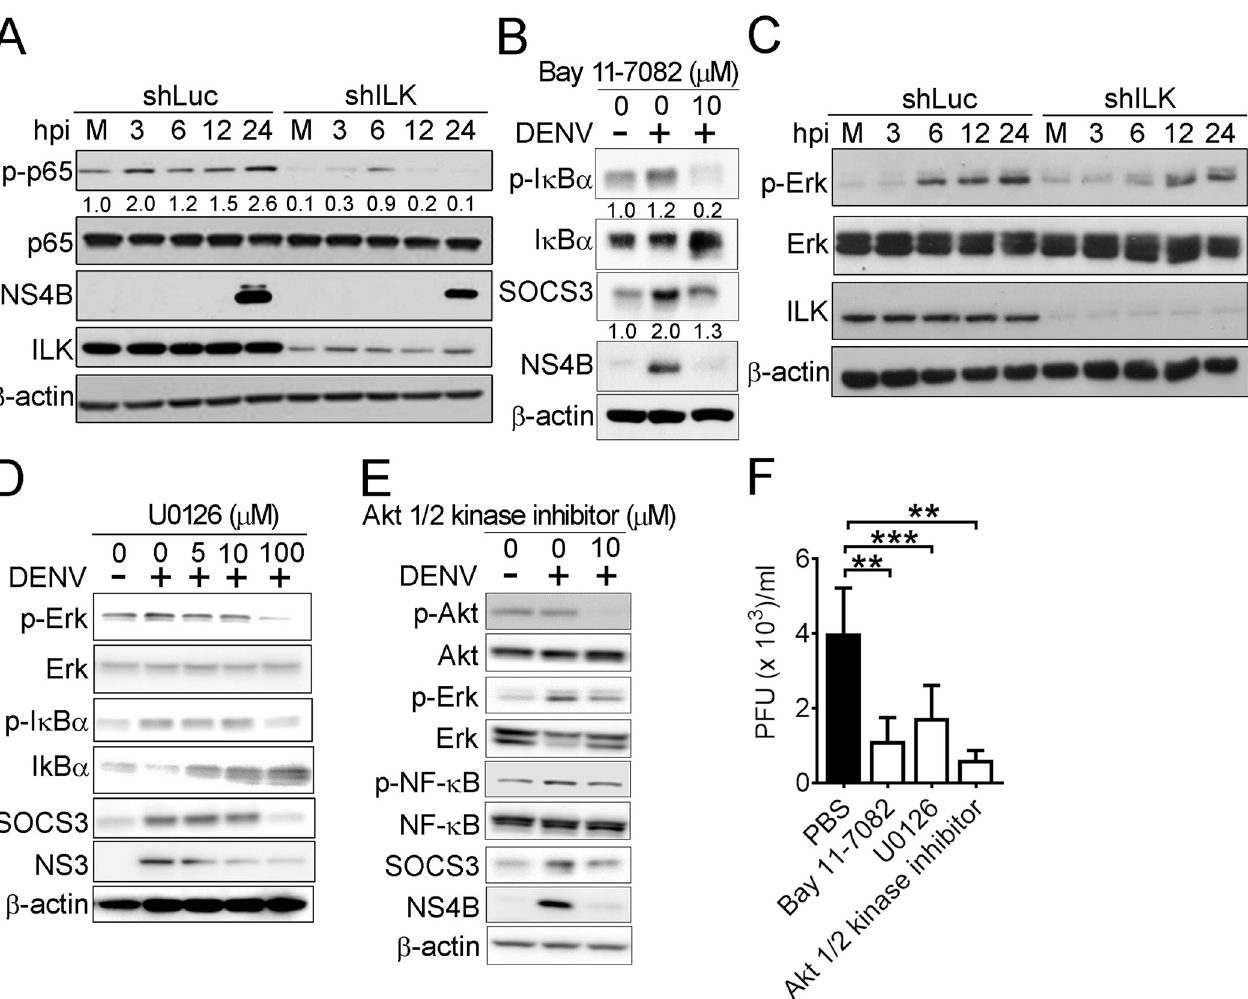
Fig 5. ILK regulates SOCS3 expression via Akt-Erk-NF- κ B pathway. ( A and C ) Representative western blots of phosphorylated (p-) and indicated proteins in mock- (M) and DENV-infected control (shLuc) and ILK knockdown (shILK) A549 cells at indicated hours post-infection (hpi) are shown. The ratios of phosphorylated to total p65 relative to mock-infected cells are shown. ( B, D, and E ) Representative western blots of indicated proteins in mock-infected (-) or DENV-infected (+) A549 cells treated with indicated concentrations of Bay 11–7082 ( B ), U0126 ( D ), or Akt inhibitor ( E ) at 24 hpi are shown. ( F ) The DENV yields in infected A549 cells treated with 10 μ M of indicated inhibitors at 24 hpi are shown. Data represent mean + SD (error bars). �� p < 0.01, ��� p <